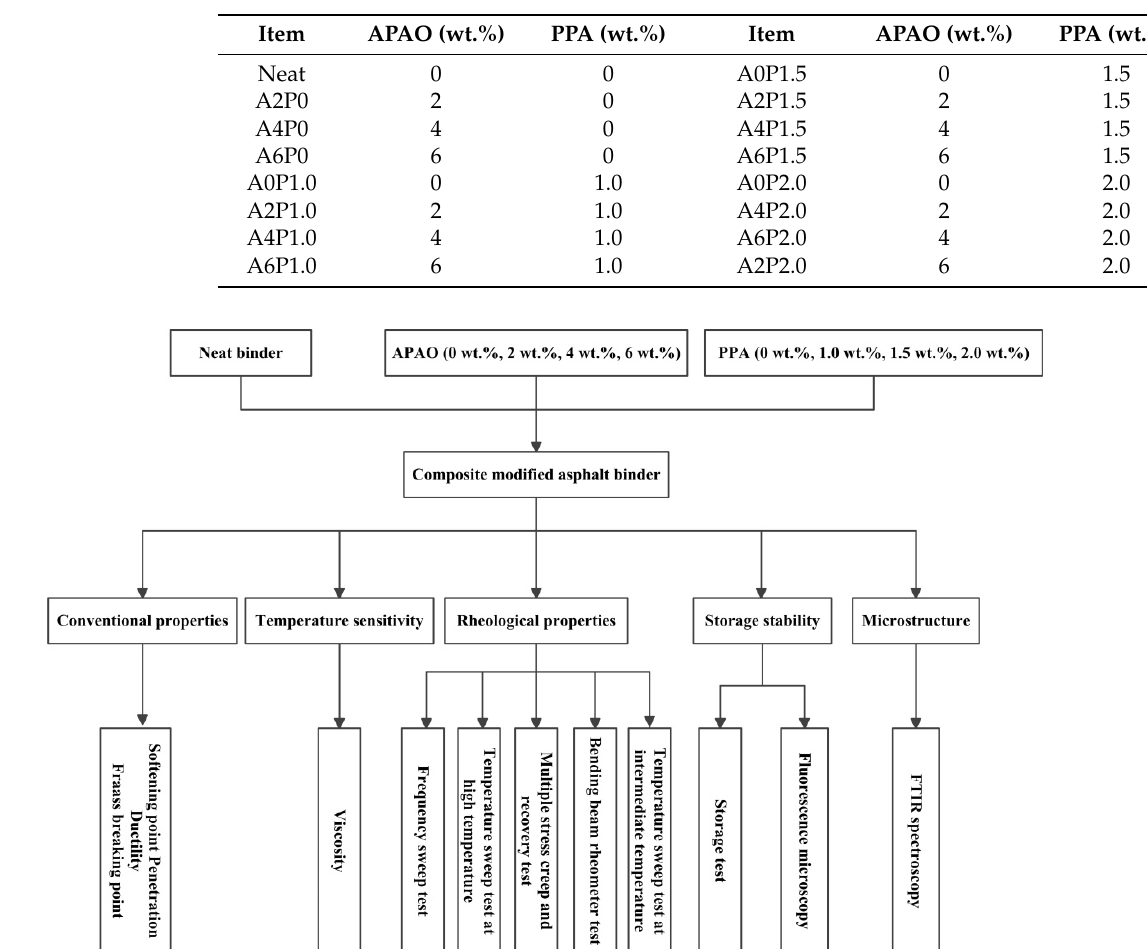
Table 4. The composition and corresponding abbreviations of all modified binders.